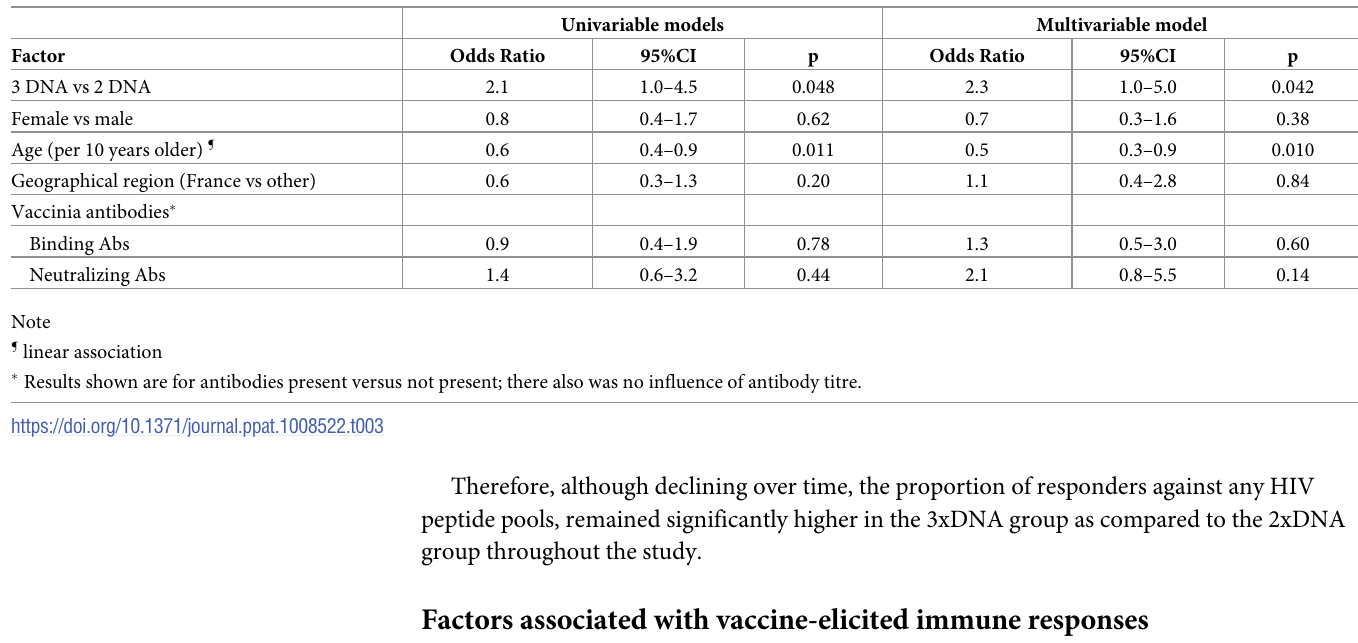
Table 3. Multivariable logistic regression analysis of predictive factors of vaccine responses to Env and Gag/Pol/Nef, EV03/ANRS VAC20 Phase I/II Trial.